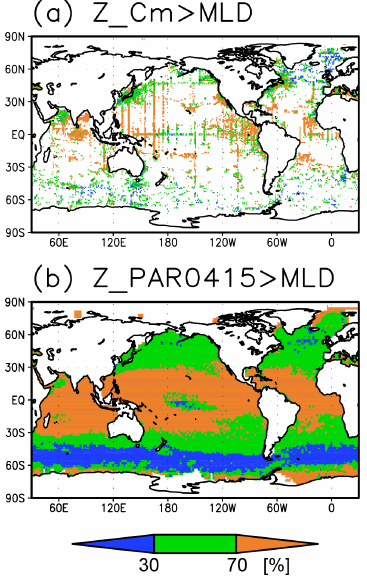
Figure 9. Percentage of months when (a) the chlorophyll a (Chl a ) maximum and (b) the photosynthetically active layer ( > 0 . 415molm − 2 d − 1 of photosynthetically available radiation) were deeper than the mixed layer. Data in grids with only one datum were